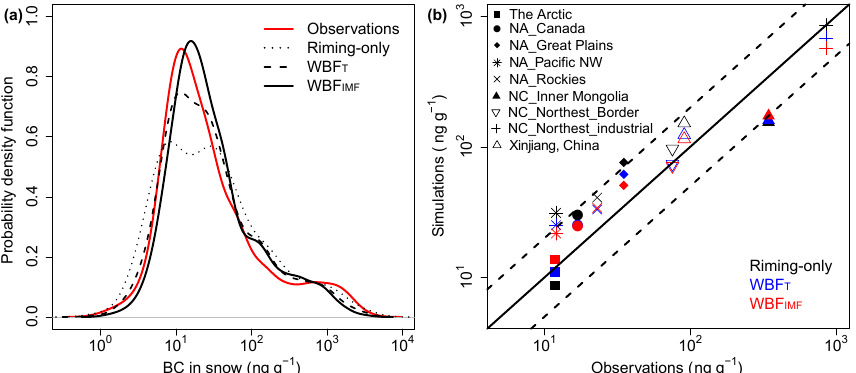
Figure 6. (a) Probability density function of observed (solid red line) and GEOS-Chem-simulated (dotted: riming-only; dashed: WBF T ; solid black: WBF IMF ) BC in snow (ngg − 1 ) and (b) medians of observed and simulated BC in snow (ngg − 1 ) in the Arctic, North America (Canada, the Great Plains, the Pacific Northwest, and the Rockies, as defined by Doherty et al., 2014)), northern China (Inner Mongolia, Northeast Border and Northeast Industrial, as defined by Wang et al., 2013), and Xinjiang, China. The regions are symbol-coded and the simulations are color-coded (see text for details). Solid line – 1 : 1 ratio line; dashed lines – 1 : 2 (or 2 : 1) ratio